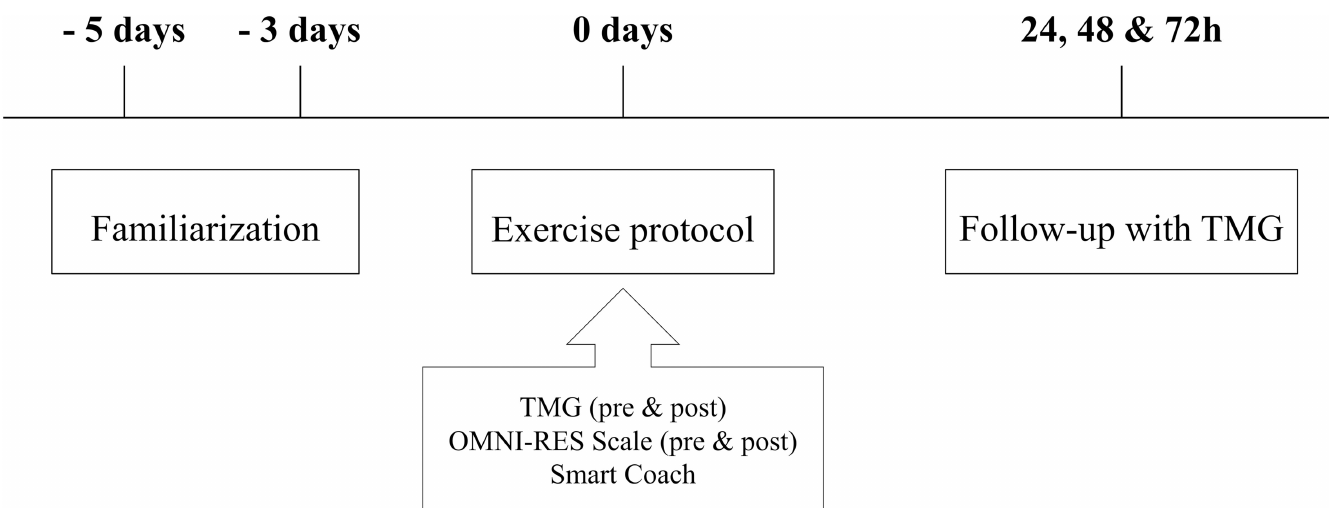
Fig 2. Schematic representation of the protocol. The specific test protocol focused on repeat power ability and consisted of four sets of seven (plus two repetitions to accelerate the inertia) unilateral coupled CON-ECC all-out hip extensions, with 30 seconds’ rest between sets (Table 2).